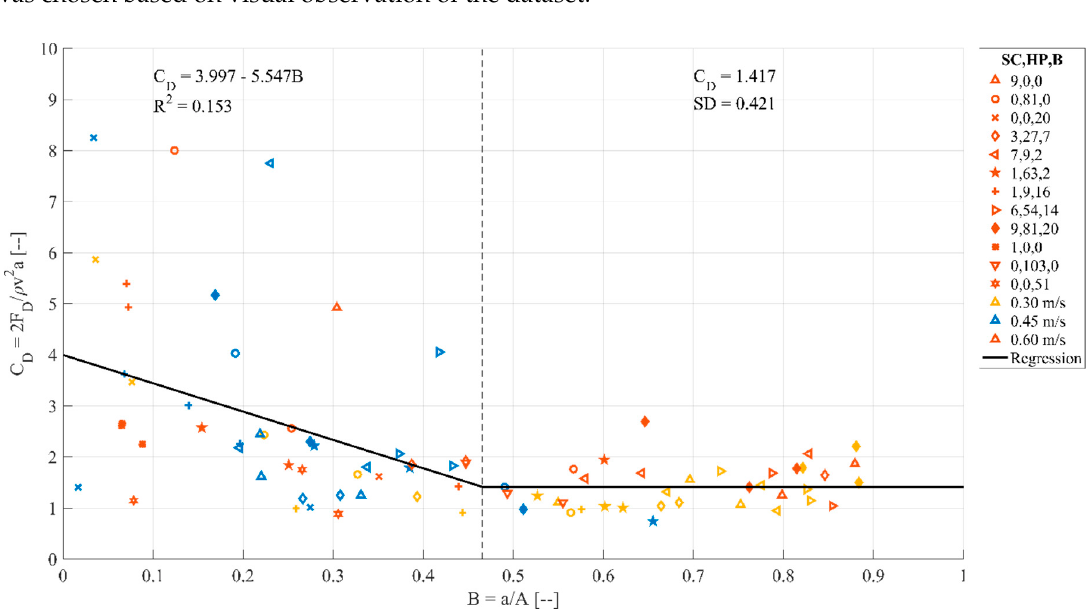
Figure 17. Drag coefficient as a function of blockage ratio. The debris configuration is shown by marker type; the hydrodynamic boundary condition by color.